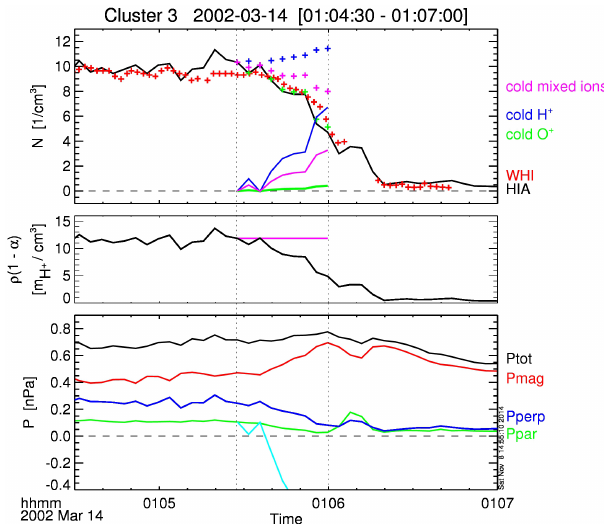
Figure 10. For the 14 March 2002 crossing, the figure shows, in the top panel, the evolution of ion (black trace) and total elec- tron densities (red plus symbols) provided by HIA and WHIS- PER, respectively. The inferred densities of cold ions, either H + (blue line) or O + (green line), or of a cold plasma mixture rich in heavy ions (magenta line) required to make ρ( 1 − α) constant dur- ing the Walén interval (vertical dotted lines) are also shown; the blue, green, and magenta plus symbols give the total electron num- ber density, including the contribution required by the hypothetical cold H + or O + ions or by the cold plasma mixture, respectively. The middle panel shows the evolution of ρ( 1 − α) . The bottom panel shows the magnetic field pressure, p mag (red), the perpen- dicular, p ⊥ (blue), and parallel, p (cid:107) (green), plasma pressures, the total pressure p tot = p mag + p ⊥ (black), as well as the hypotheti- cal p (cid:107) (cyan trace) needed to make ρ( 1 − α) constant (only values above − 0.4nPa are